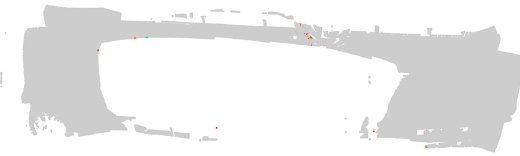
Figure 25. Display of upper deviation and lower deviation obtained by error detection.